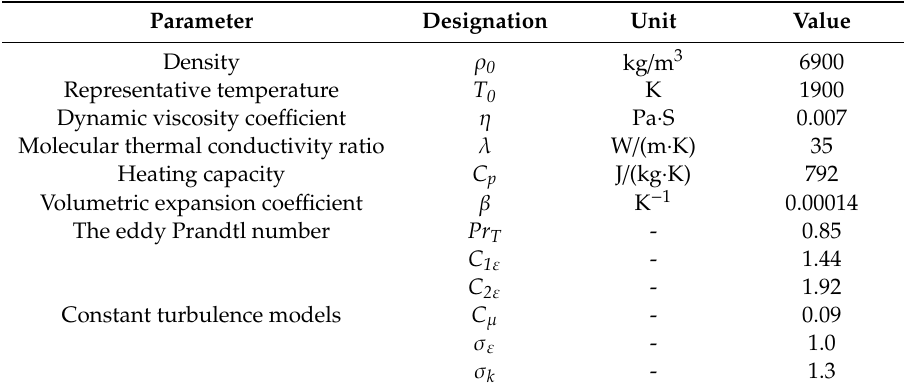
Table 1. The molten steel properties and the turbulence model